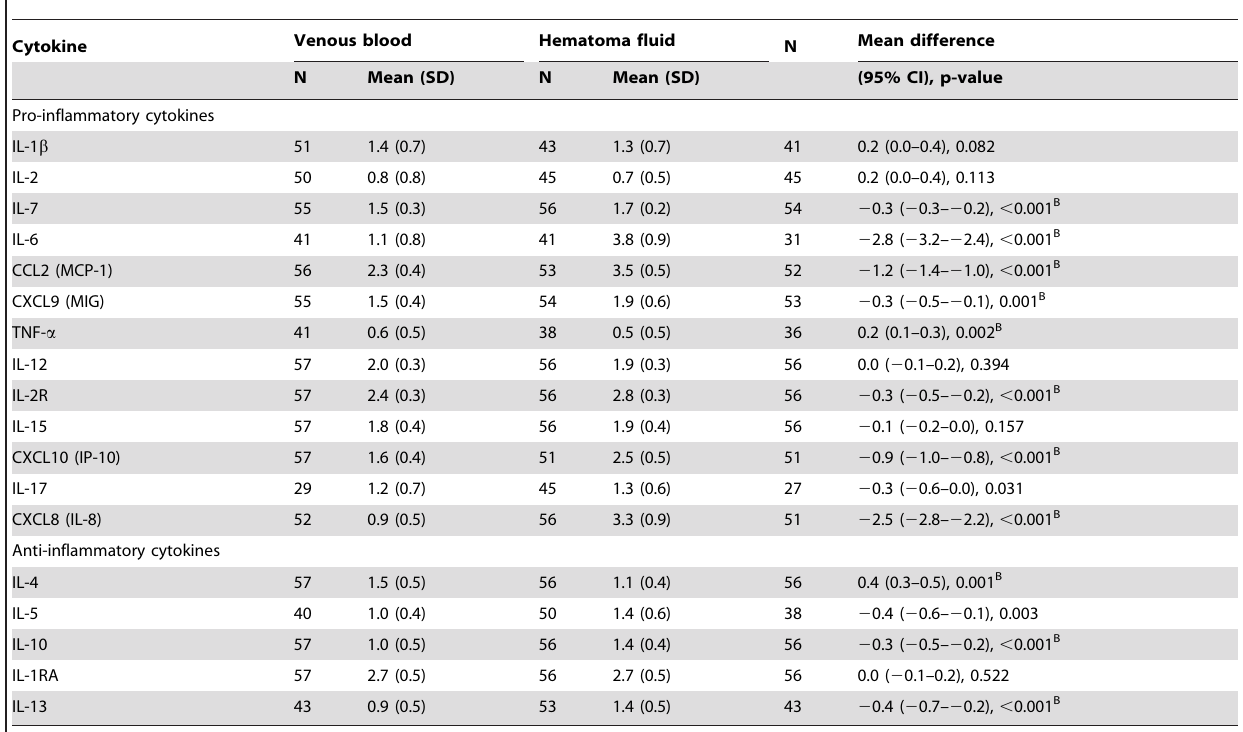
Table 1. Concentration of cytokines (log pg/ml) in venous blood and hematoma fluid samples.